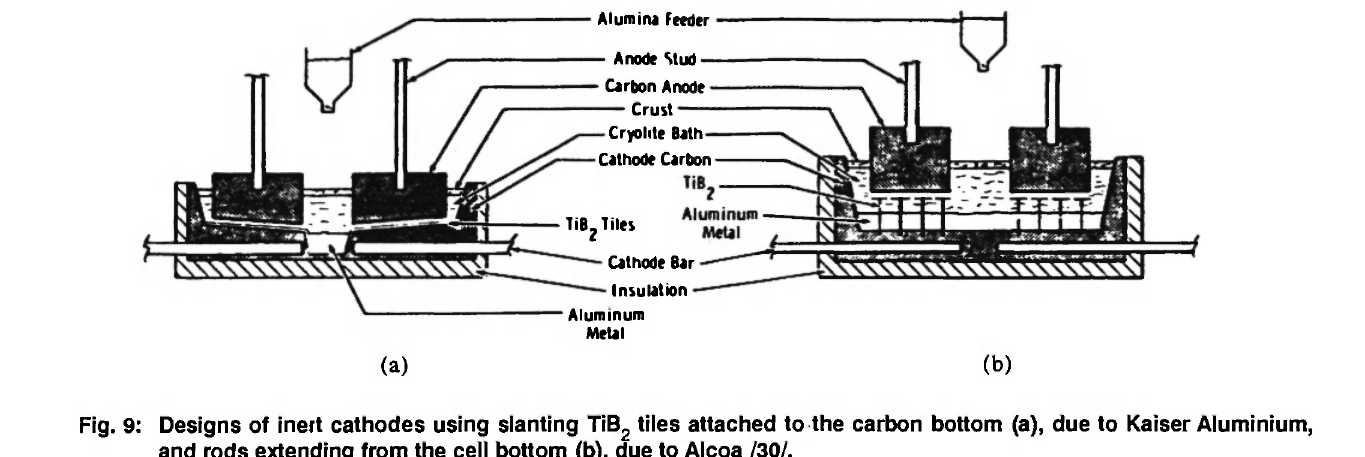
Fig. 9: Designs of inert cathodes using slanting TiB 2 tiles attached to the carbon bottom (a), due to Kaiser Aluminium, and rods extending from the cell bottom (b), due to Alcoa /30/.